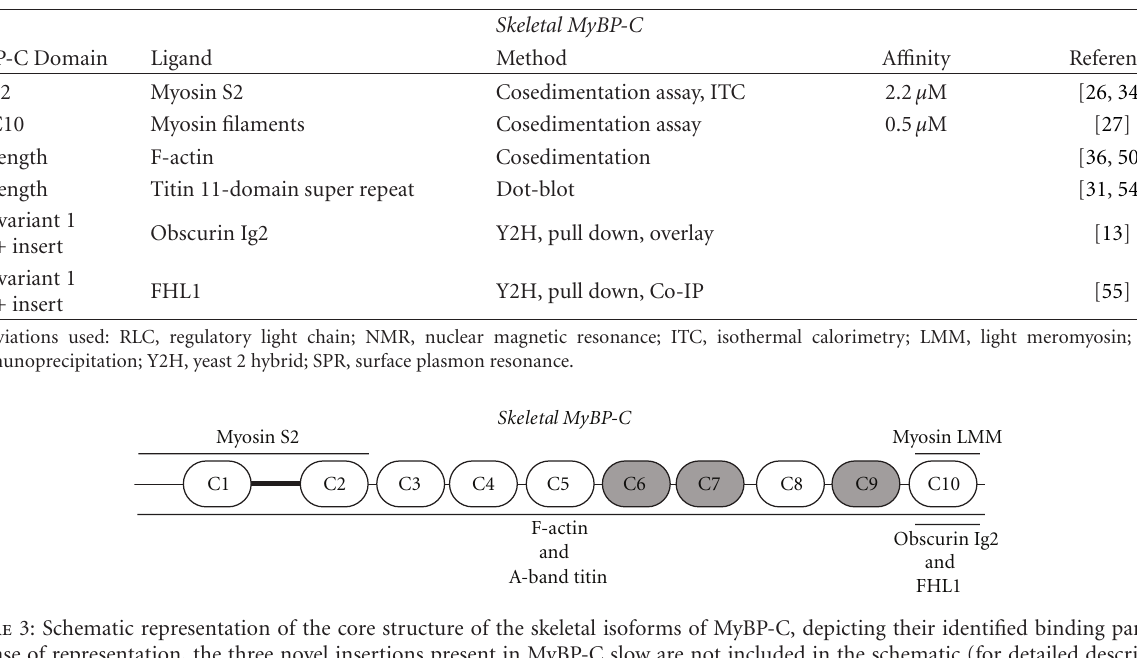
Table 2: Ligands of the skeletal isoforms of MyBP-C.